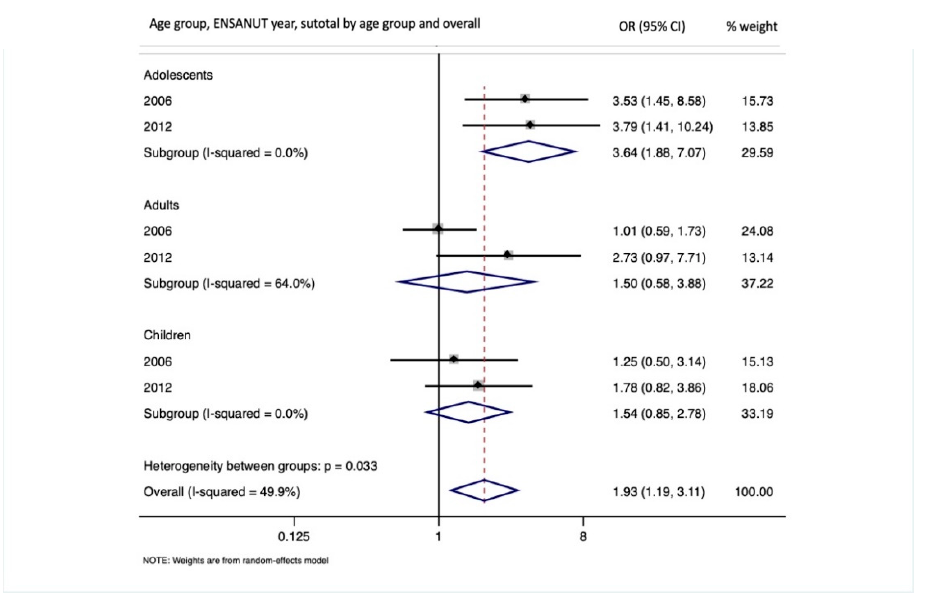
Figure 1. Associations between quartiles of PM 2.5 (annual mean) and obesity in three age groups, ENSANUT 2012.